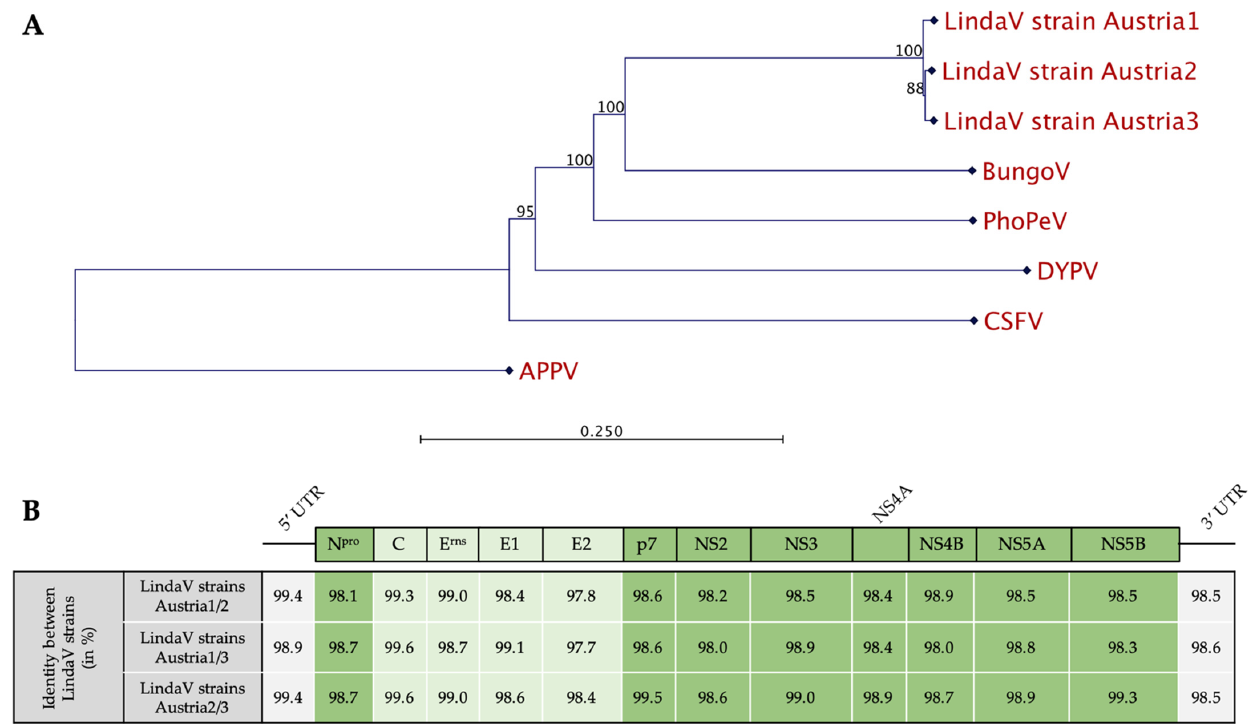
Figure 4. Phylogenetic analysis of selected pestivirus species and sequence analysis of the full- genomic sequences of the so far known Linda virus strains. ( A ) An unrooted phylogenetic tree was constructed based on the full-genomic sequences of LindaV strain Austria1, LindaV strain Austria2, LindaV strain Austria3, Bungowannah virus, Phocoena pestivirus isolate NS170386, Dongyang pangolin pestivirus isolate DYAJ, CSFV strain Alfort_187, and APPV strain AUT-2016_C using the neighbor-joining algorithm and bootstrapping with 1000 replicates. Bootstrap values are shown in percentage at each node. ( B ) Sequence identities between the different coding regions of the viral genome of LindaV strains Austria1, Austria2, and Austria3 are given in percentage. The coding regions for the nonstructural proteins are highlighted in dark green and coding regions for the structural proteins are in light green. DYPV, Dongyang pangolin pestivirus; PhoPeV, Phocoena pestivirus; BungoV, Bungowannah virus; APPV, atypical porcine pestivirus; CSFV, classical swine fever virus; UTR, untranslated region; C, Core; E, envelope glycoprotein; NS, nonstructural